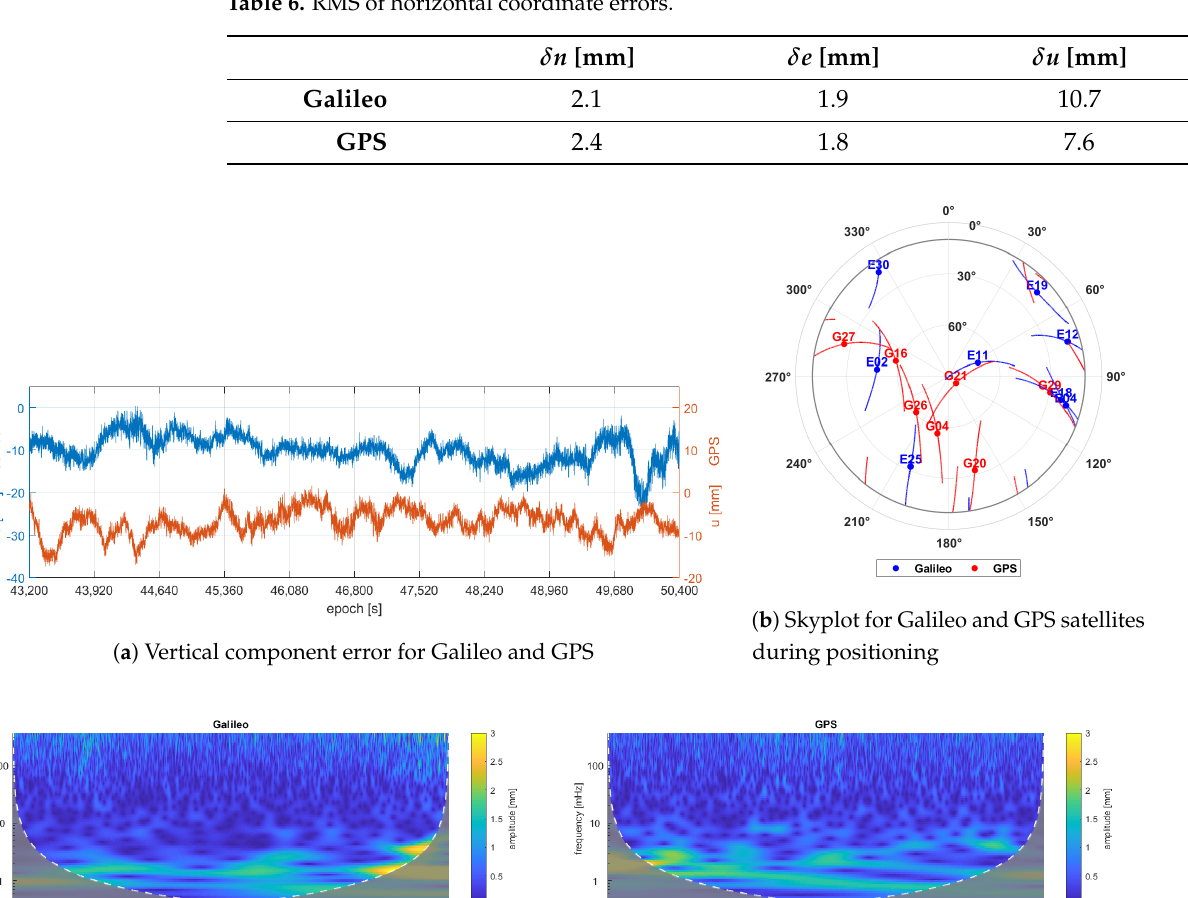
Table 6. RMS of horizontal coordinate errors.